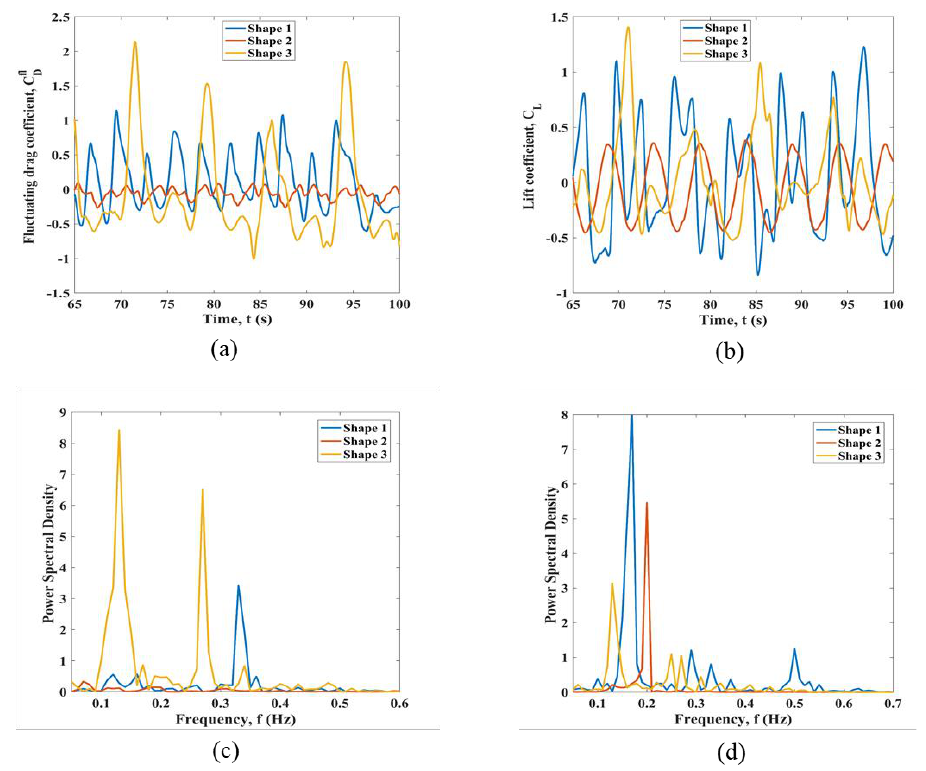
Figure A15. Fluid force coefficients for cylinder 6 immersed in uniform flow: ( a ) time history of the fluctuating drag coefficient; ( b ) time history of the lift coefficient; ( c ) the fluctuating drag coefficient FFT; ( d ) the lift coefficient FFT.